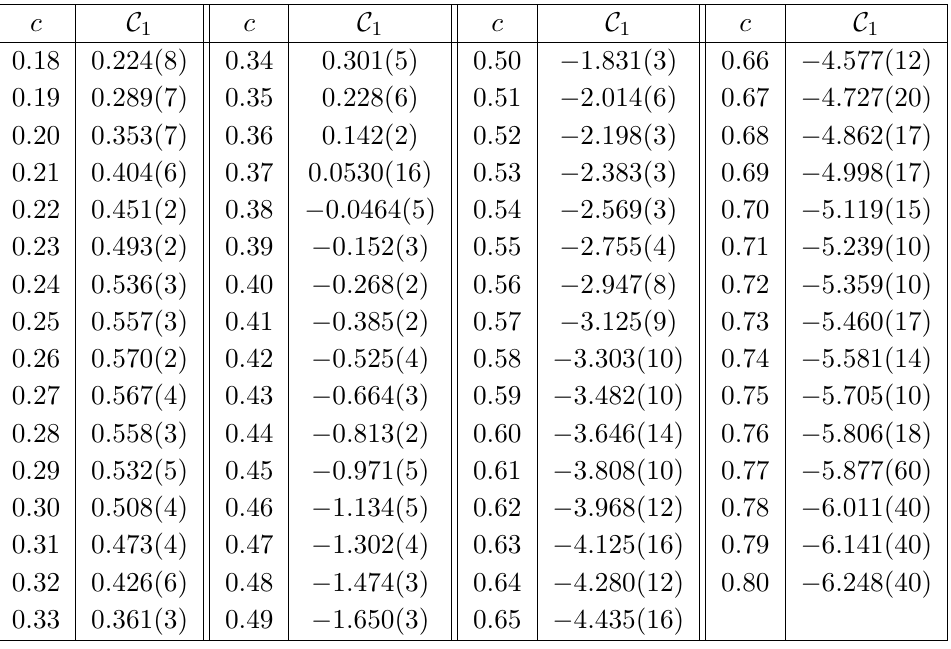
Table 1. Results for C 1 for the SU(3) gauge group and a range of values of c .